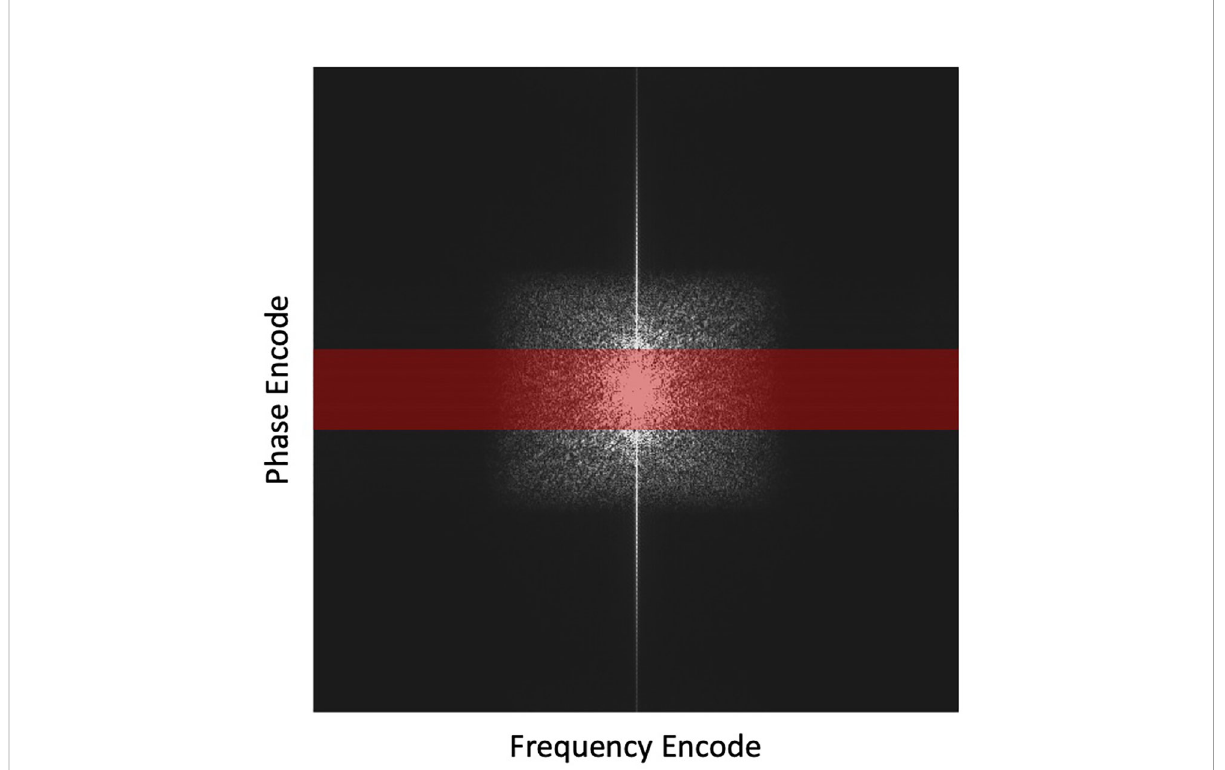
FIGURE 3 Highlighted region in red depicts the undersampling scheme with the frequency encoding =512 points and phase encoding reduced from 512 to 64 lines (by 8 times). This undersampling scheme is overlaid on a fully sampled k-space for illustration